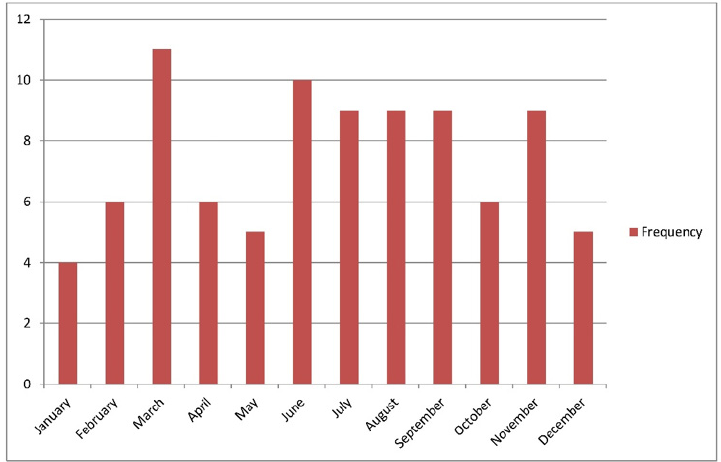
Figure 1. Showing the frequency of IgA vasculitis cases throughout the year. Arthritis was the presenting symptom in 66 (74.2%) cases, with a mean duration of 3.69 ± 3.81 days. The mean duration of arthritis was 10.61 ± 5.83 days for patients with arthritis and 10.00 ± 6.00 for patients without arthritis, which was not a significant difference ( p =